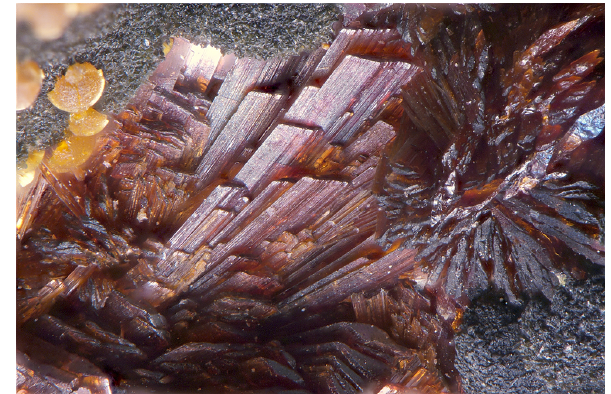
Figure 5. Dark red beraunite crystal clusters with yellowish-brown hemispheres of cacoxenite. National Museum Prague, P1N 18943 (neotype specimen, sampleNM). FOV 1mm. Photo L.